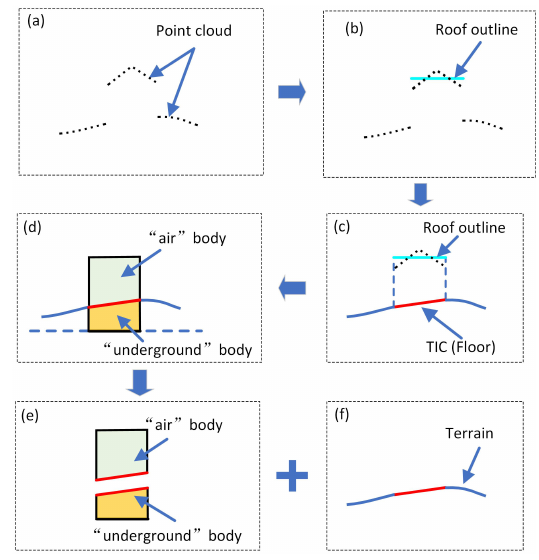
Figure 8. The process of modelling based on point cloud